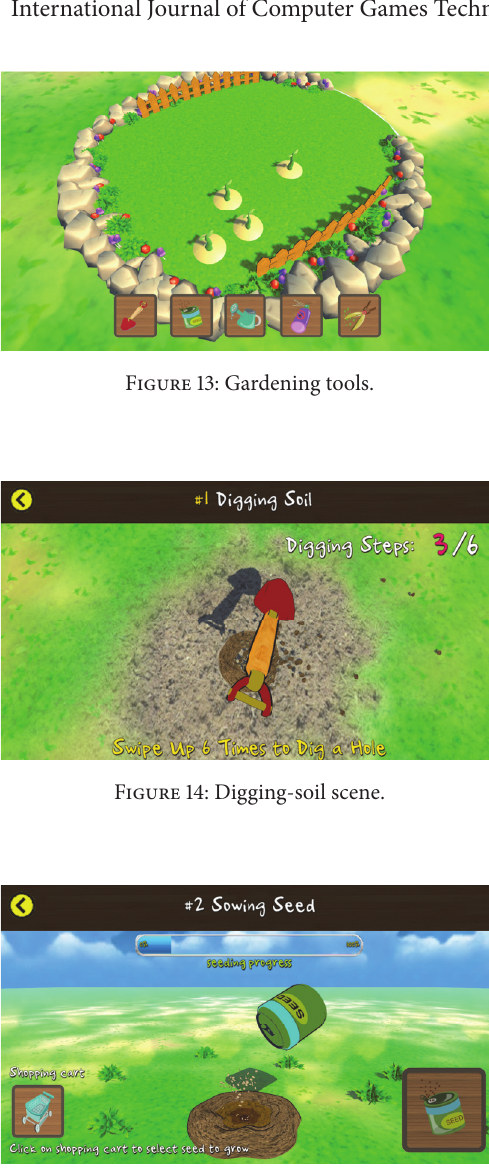
Figure 15: Sowing-seed